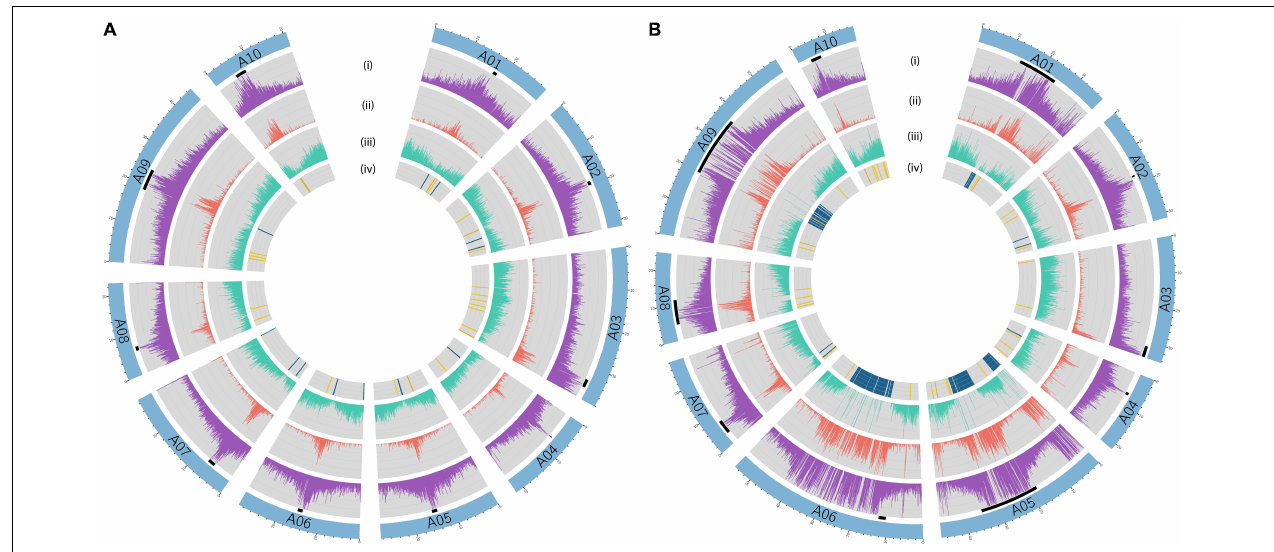
FIGURE 2 | Circular diagrams of the chromosomes of (A) B. rapa ‘Chiifu’ and (B) B. rapa ‘Z1.’ Black boxes represent chromosomes centromeric regions. Rings represent: (i) density of transposable elements, (ii) density of LTR, (iii) density of genes, and (iv) presence–absence of ribosomal DNA (45S in blue and 5S in yellow).